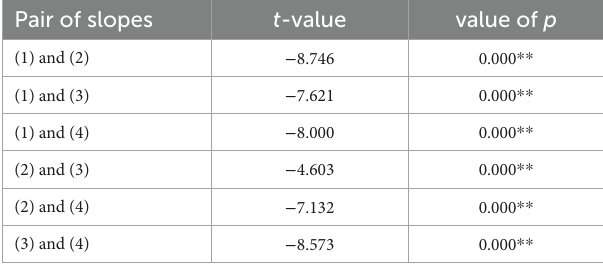
TABLE 3 A significance test of differences between pairs of slopes for the bullying victimization on psychological distress. Pair of slopes t